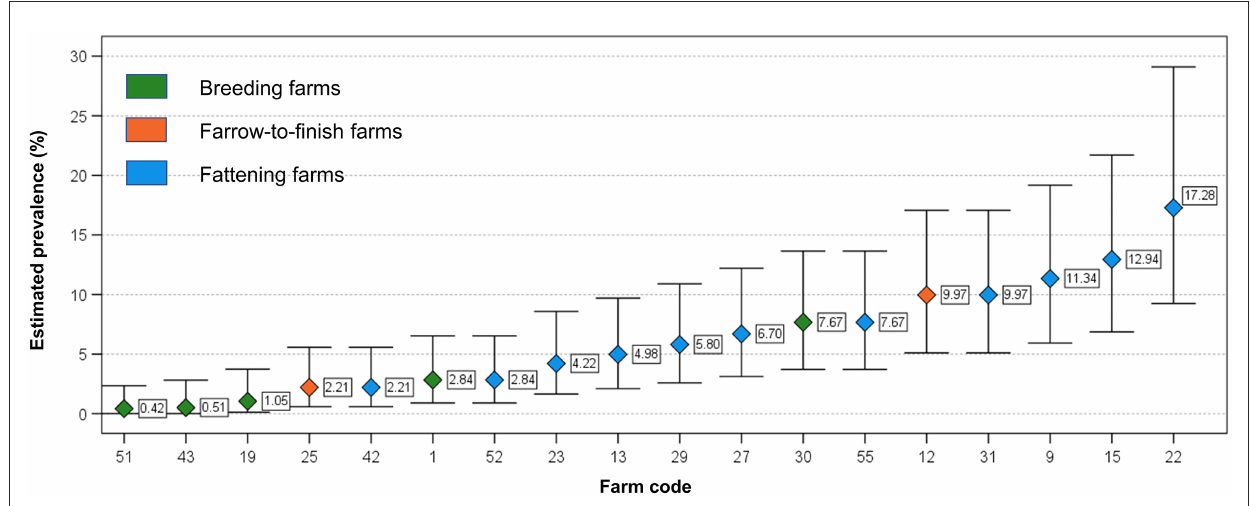
FIGURE2 Distribution of estimated prevalence in the examined HEV positive herds (with at least 1 positive pooled sample). Whiskers indicate 95% Confidence Interval.